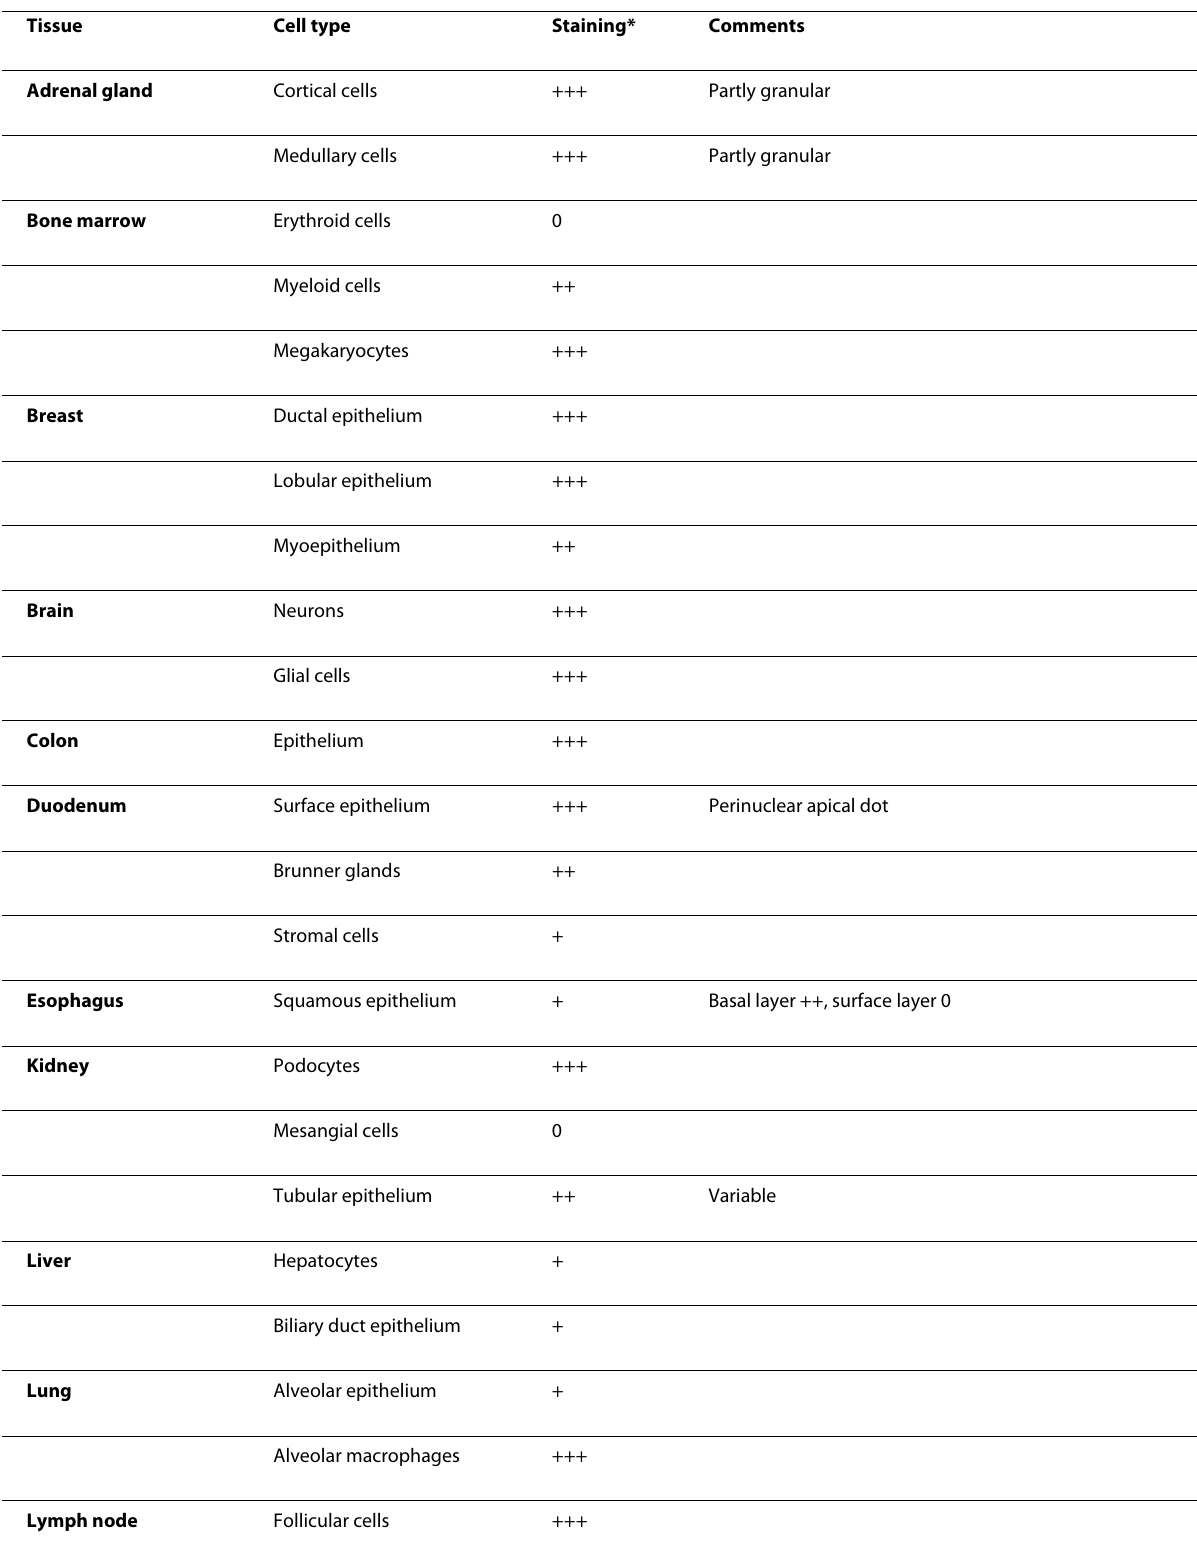
Table 1: Expression of FMNL2 in various tissues and cell